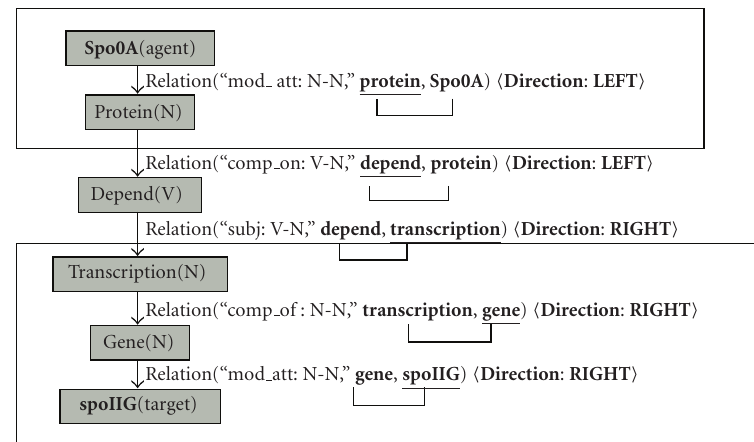
Figure 1: Example of a syntactic path based on LLL05 annotations.